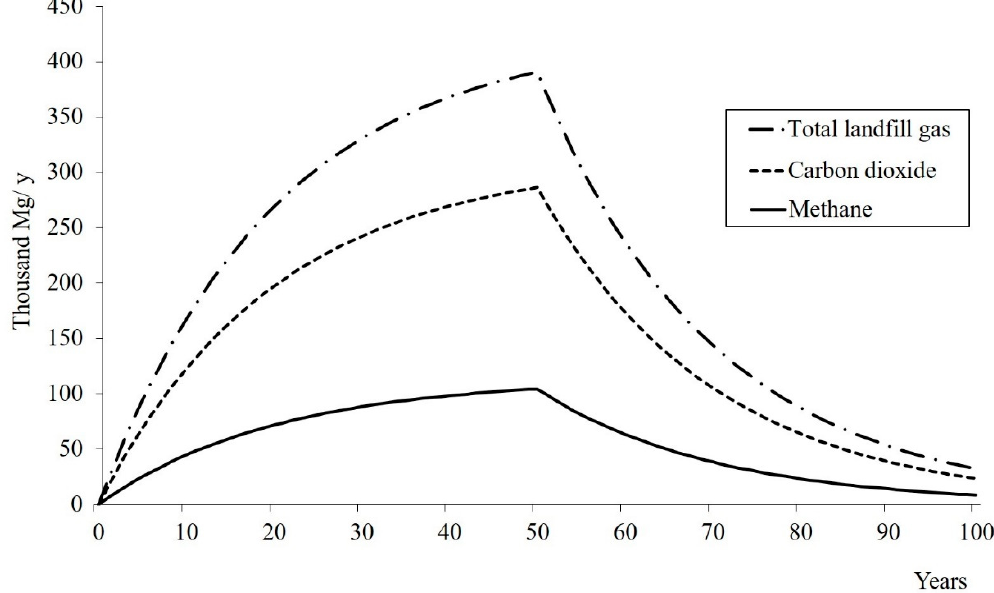
Figure 3. Simulated landfill gas production by using the model LandGEM.